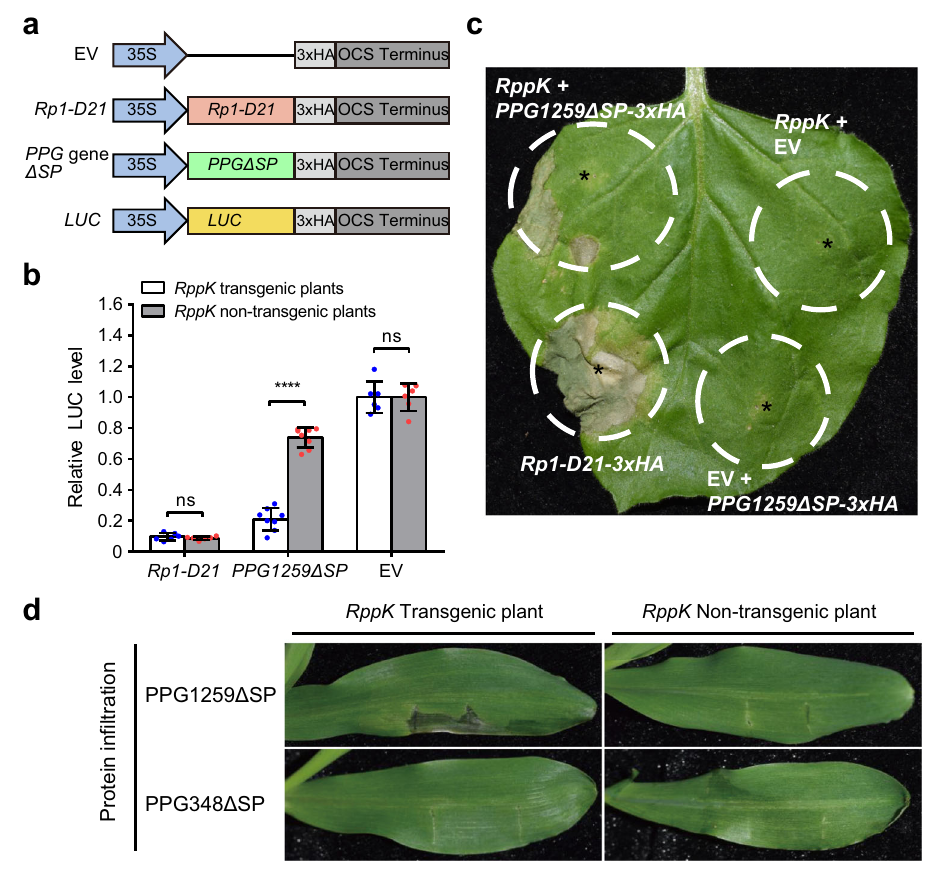
Fig.3| PPG1259 isthecognateavirulencegeneof RppK .a Schematicdiagramsof constructs for AvrRppK gene screening in transient protoplast expression assays. EVistheemptyvector; Rp1-D21 wasusedasthepositivecontrol; PPG genesfrom P. polysora wereclonedbyusingmRNAisolatedfrom P.polysora -infectedleaves; Δ SP indicates deletion of the signal peptide region; and the LUC construct was used to evaluate cell viability in the transient protoplast expression assay. b PPG1259 Δ SP expression in the protoplasts of RppK transgenic plants induced an HR but its expression in the protoplasts of nontransgenic plants did not. PPG1259 Δ SP was coexpressed with the 35s:LUC construct in the protoplasts of RppK transgenic plants or nontransgenic plants; the Rp1-D21 gene or empty vector (EV) was coex- pressed with the 35s:LUC construct in this assay as a positive or negative control, respectively. Relative LUC levels were measured to indicate the viability of proto- plasts. Valuesare means±SDs (forexpression of PPG1259 Δ SP , n =8;for the others, n =6; P =0.4466, 3.4E-10, 1). ** P <0.01; ns, not signi fi cant (two-tailed Student ’ s t